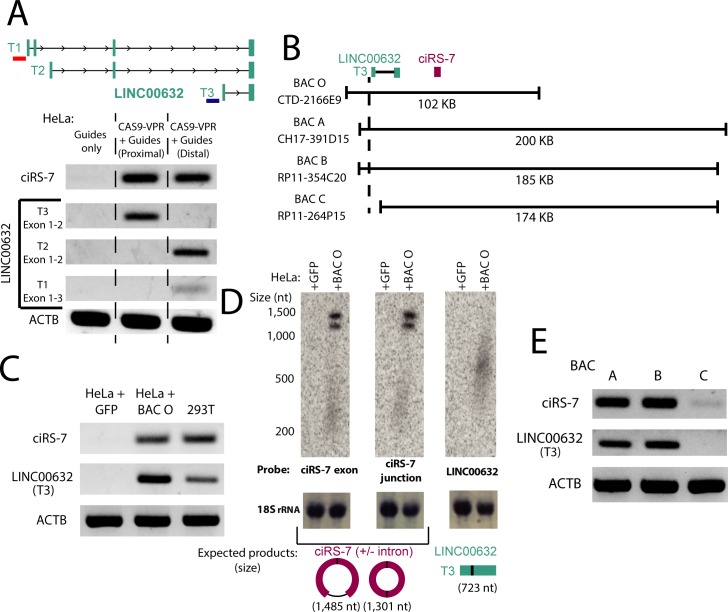
Experimental approaches confirm the identity of the ciRS-7 promoter.(A) RT-PCR for ciRS-7 and LINC00632 transcripts in HeLa cells (+/- Cas9-VPR activation) with guide RNAs targeting distal and proximal promoters identified in Fig 1C. The approximate targeted locations of the proximal and distal guide RNAs are shown with a blue and red bar, respectively, in the diagram shown above the gel. (B) Schematic of BAC inserts with respect to the ciRS-7 and LINC00632 genes. (C) RT-PCR and (D) Northern blot for ciRS-7 and LINC00632 transcripts generated after BAC O transfection. The appearance of two bands in the ciRS-7 Northern blots is due to alternative splicing of an intron contained within the ciRS-7 exonic sequence. (E) RT-PCR for ciRS-7 and LINC00632 transcripts from HeLa cells transfected with BACs A-C.